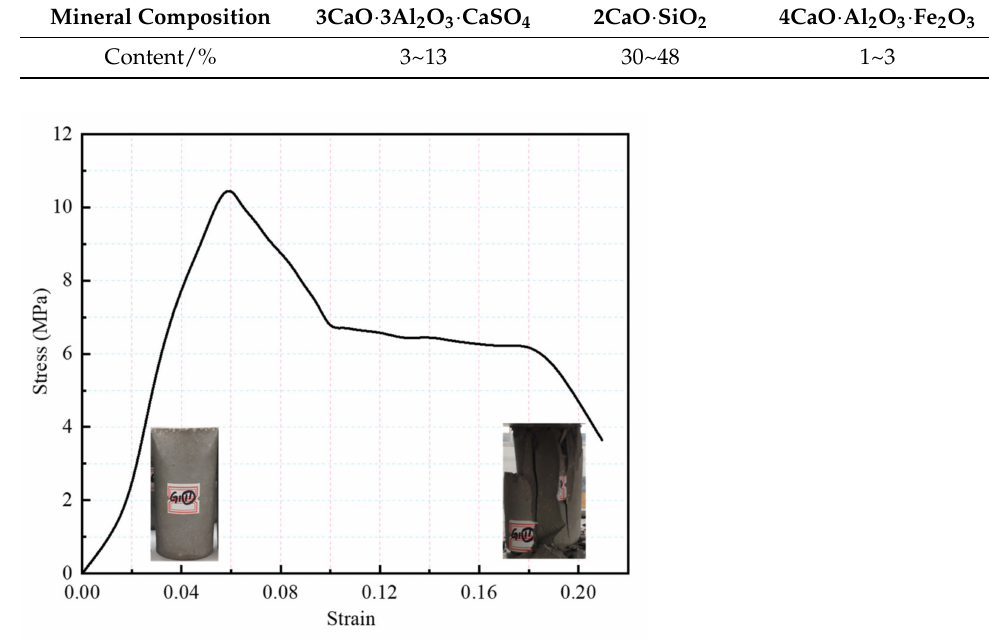
Figure 16. Full stress strain curve of high-water